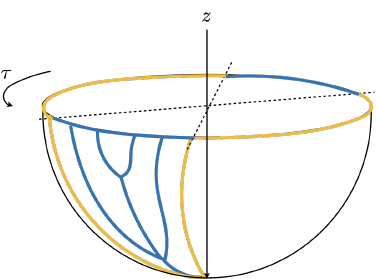
Figure 3 . Cartoon of the dominating configurations: as the boundary time separation increases, the U penetrates more and more into the bulk pulled by the vertical segment (blue configurations in blue zone). Eventually the tip of the U hits z = 1 and the only configuration is the straight one (yellow configurations in yellow